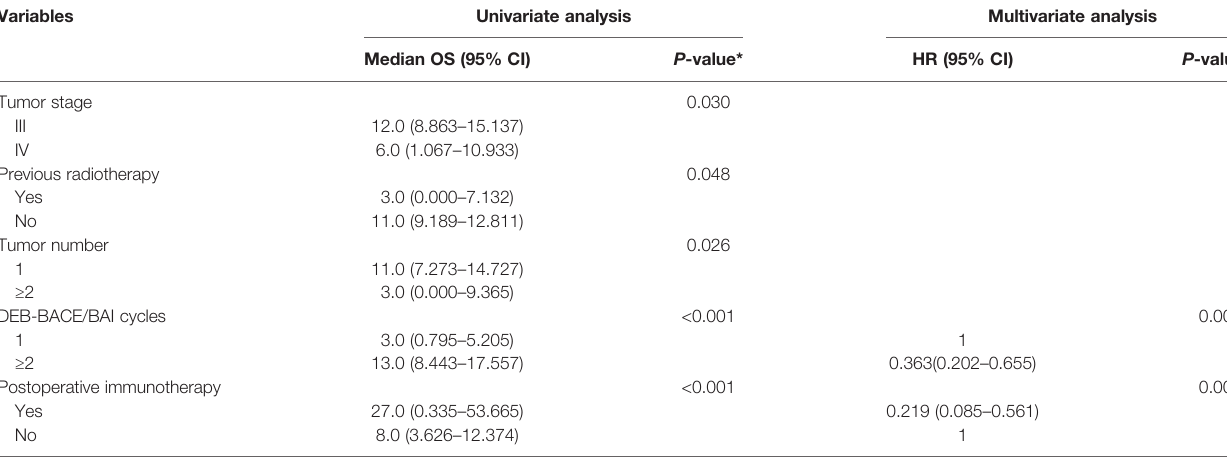
TABLE 5 | Univariate and multivariate Cox proportional hazards analyses for OS in ASTRI-NSCLC treated with DEB-BACE.